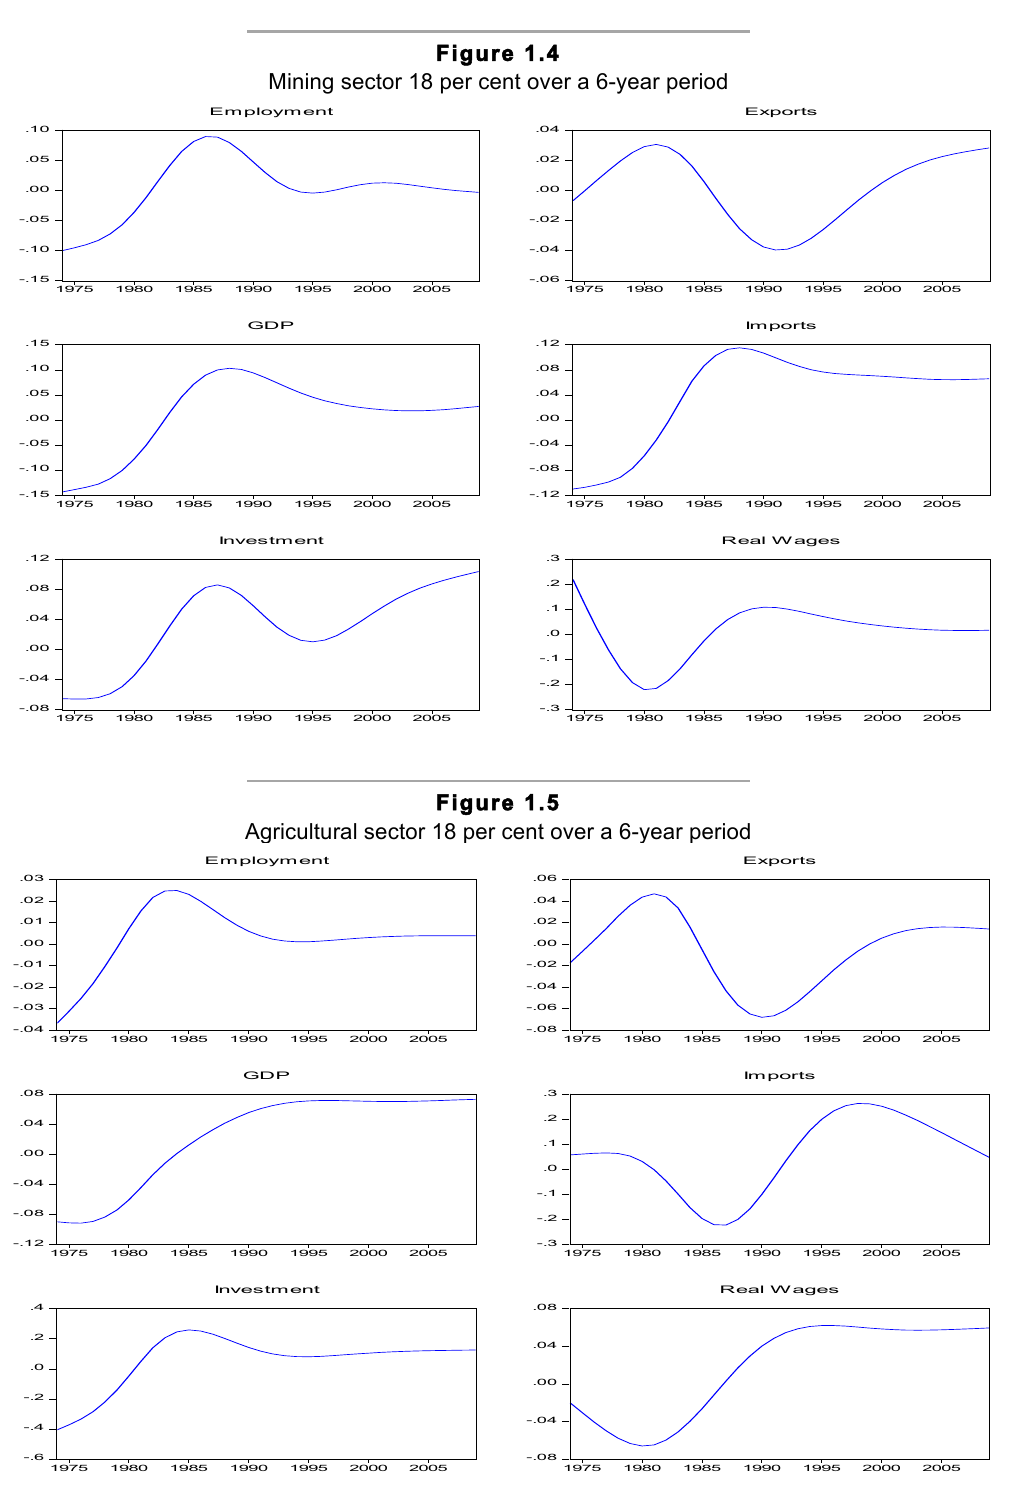
Mining sector 18 per cent over a 6-year period